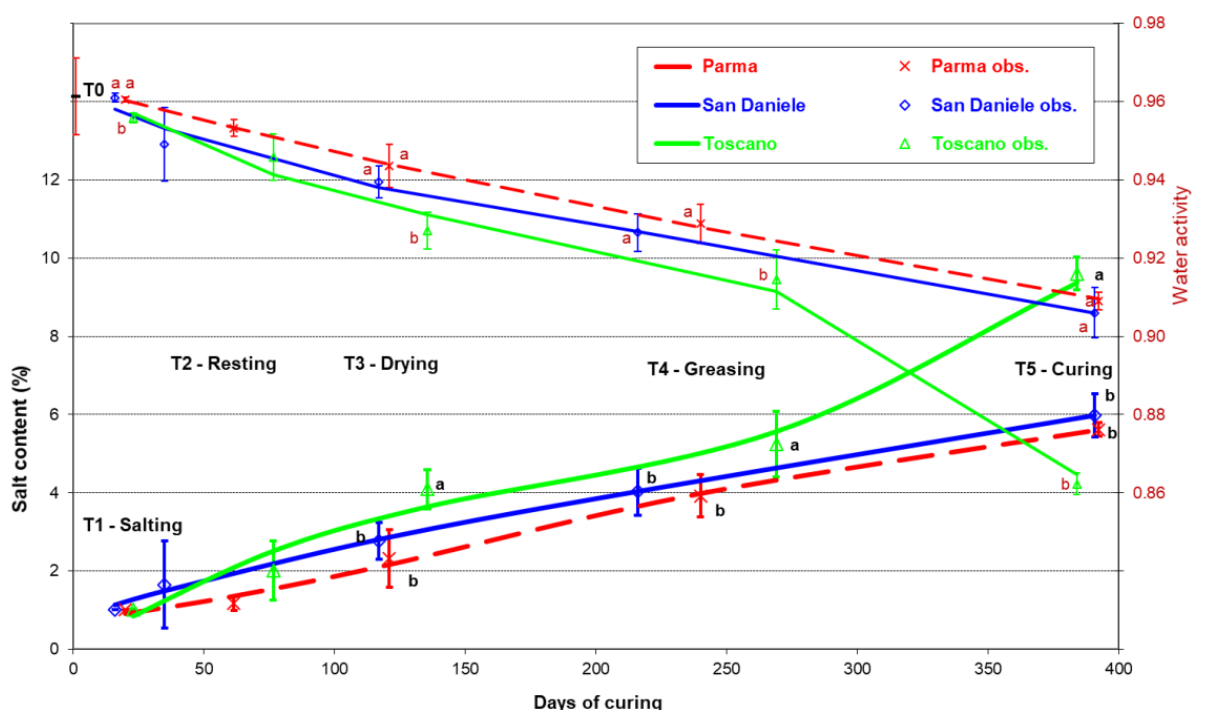
Figure 2. Evolution of the salt content and a w in the biceps femoris muscle during the processing of the main Italian prosciutto PDOs (obs. = observed mean with standard deviation values; a, b: differences between PDOs within the ripening phase p ≤